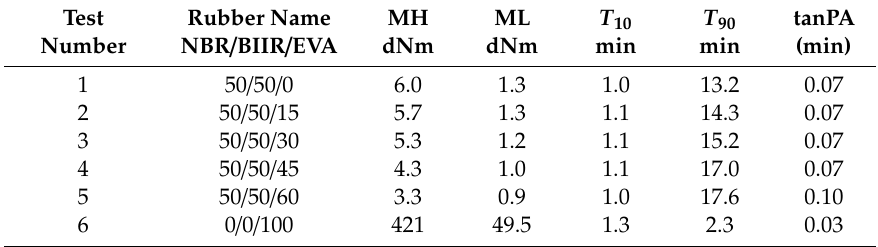
Table 5. Vulcanization characteristic parameters of NBR / BIIR / EVA with various blend ratios (150 ◦ C). Test